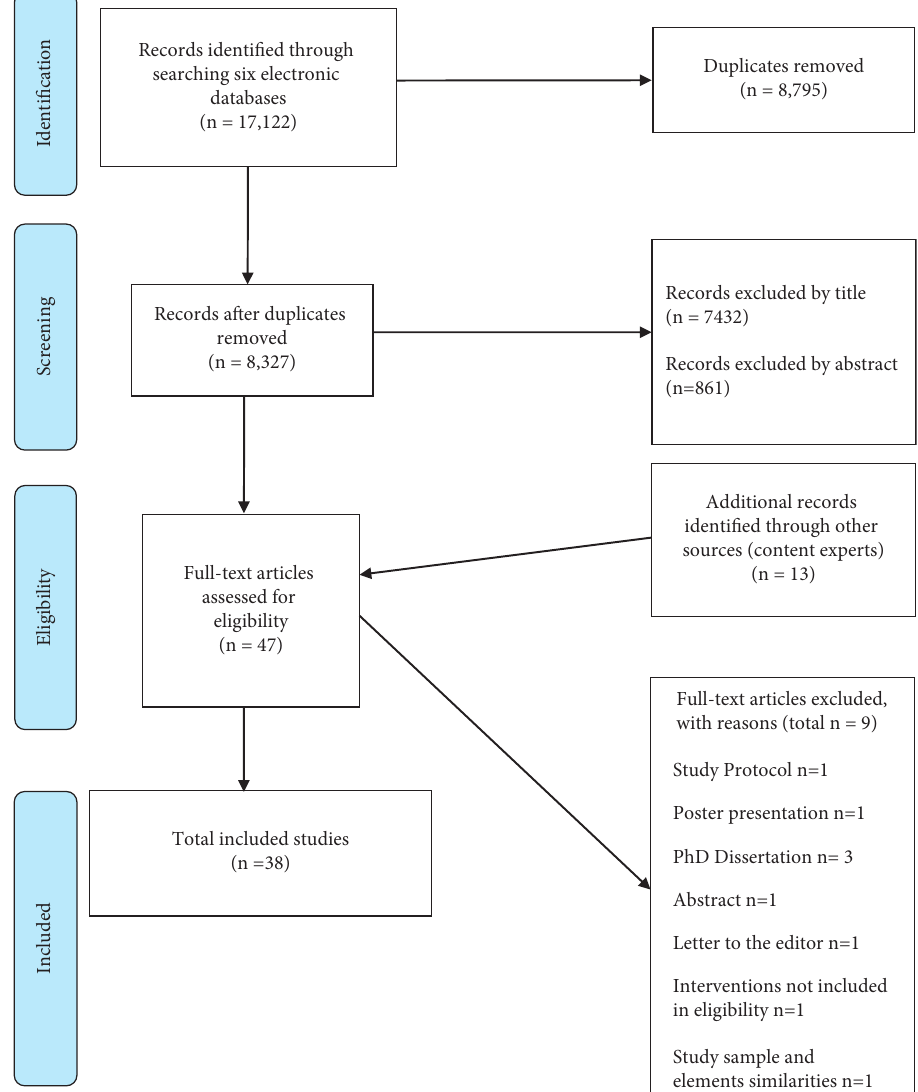
Figure 1: PRISMA flow